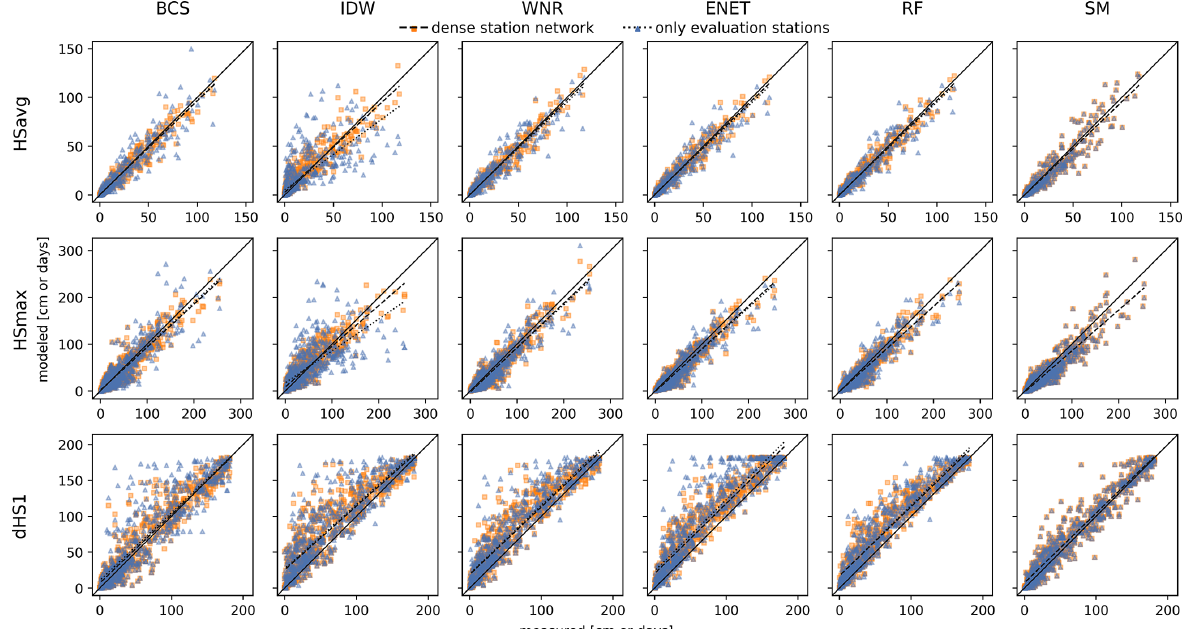
Figure 4. Modeled average snow depth in a winter (HSavg, top row), maximum snow depth in a winter (HSmax, middle row) and number of snow days with HS ≥ 1cm (dHS1, bottom row) of the reconstructed winters from the cross-validation trials versus the respective snow climate indicator value derived from measurements. The columns refer to the different interpolation methods. Orange squares are gaps reconstructed with the complete station network, and blue triangles are gaps that have been reconstructed solely using the evaluation stations as depicted in Fig. 1. The black line represents perfect predictions. The dashed and dotted lines are linear fits to the data points of the dense and sparse station networks,